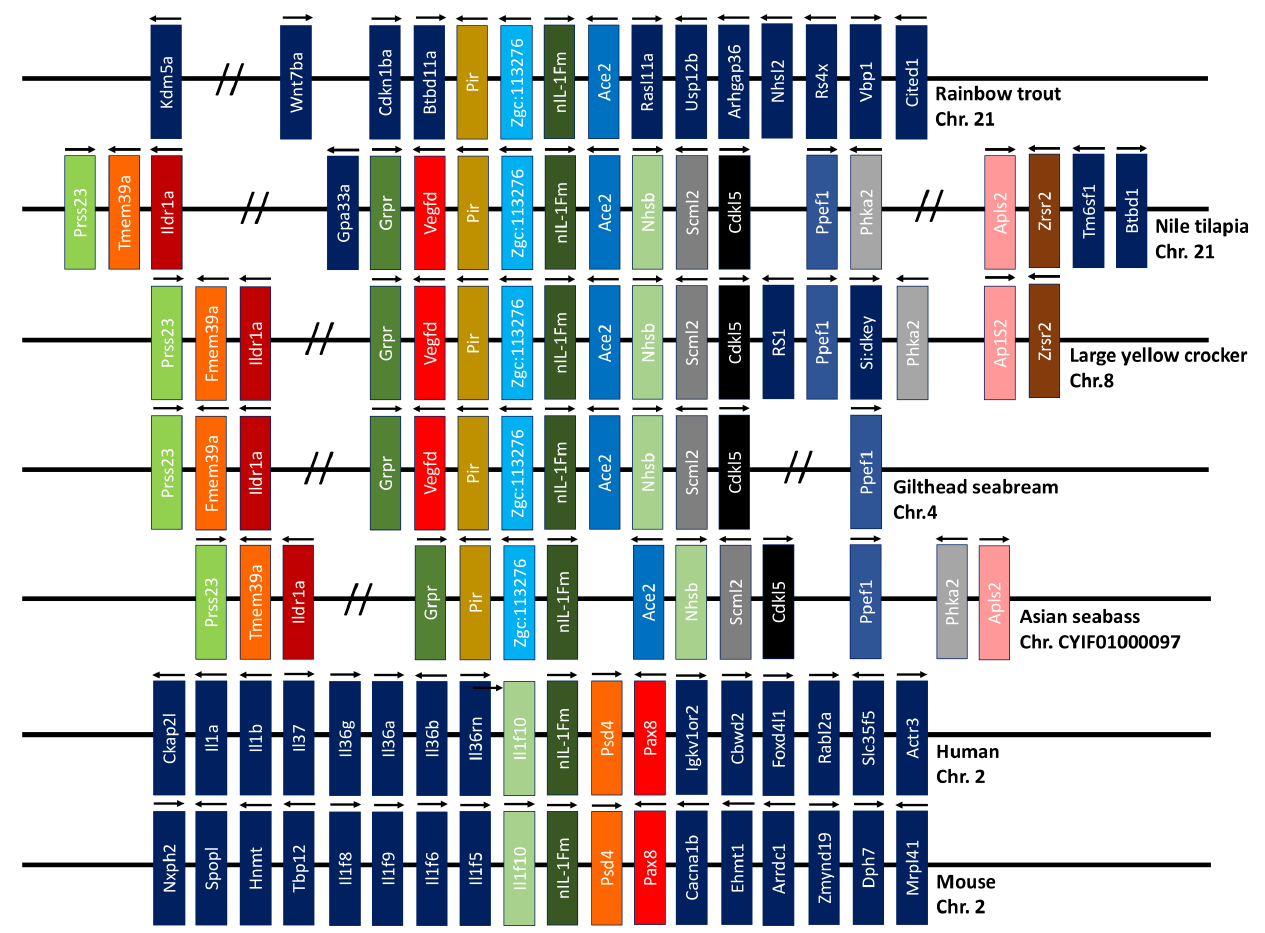
Figure 3. Comparison of the gene organization of Nile tilapia nIL-1Fm gene with nIL-1Fm genes of other fish and